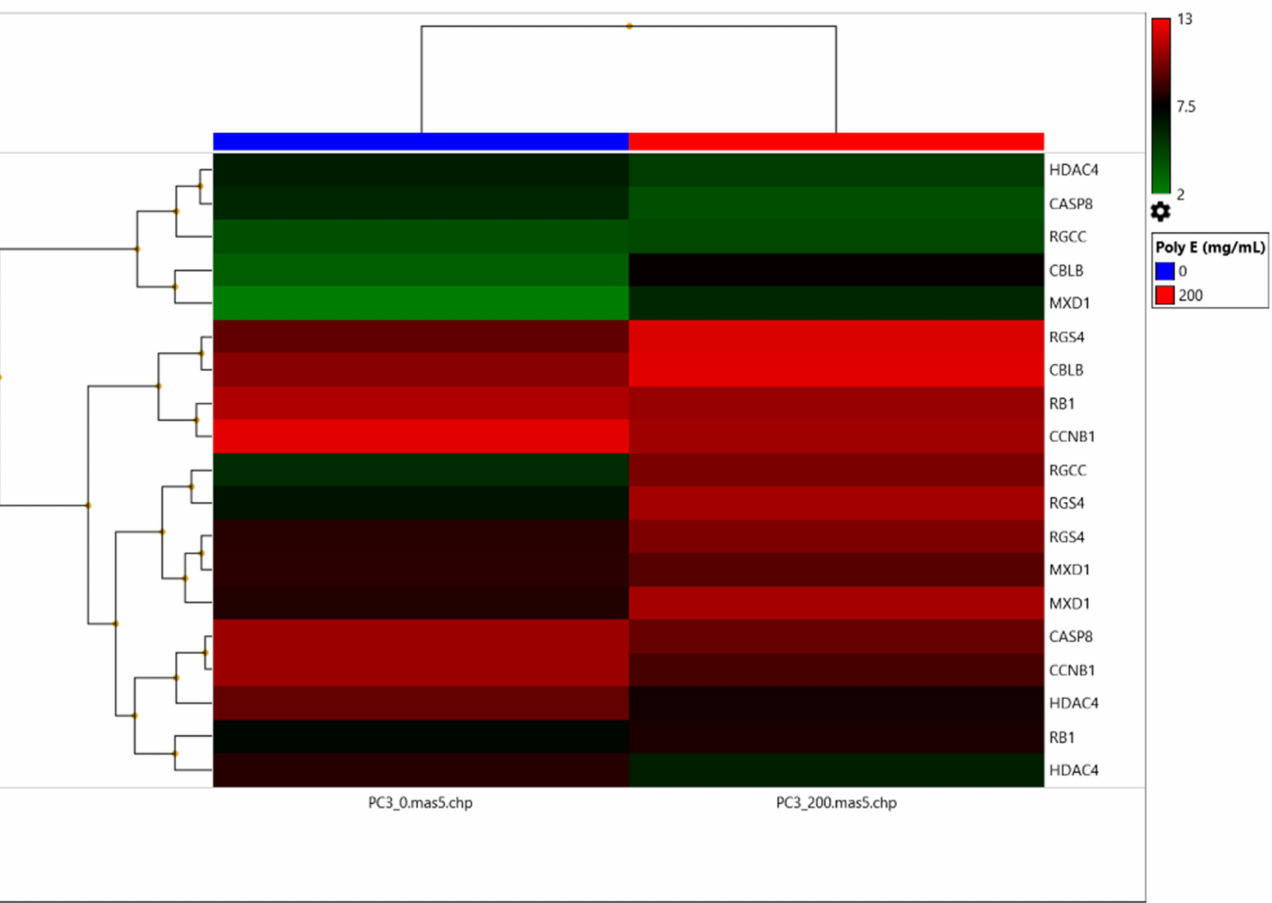
Figure 3. Poly E-treated PC-3 cell line microarray gene expression hierarchical clustering. Reporter probe signal intensities of the eight genes selected for qRT-PCR analysis are labeled with red rep- resenting upregulation and green representing downregulation in gene expression, relative to the middle-adjusted intensity depicted in black. A scale of signal intensity values ranging from 2 (lowest) to 13 (highest) is depicted at the top right of the heat map. Columns represent either untreated ( left ; 0 mg/L) or Poly E-treated ( right ; Mid 200 mg/L). Rows represent individual Affymetrix probes with gene symbols displayed to the right of each row. Hierarchical clustering of the genes analyzed is indicated by the nodal connections (left side of figure). Gene symbols (right side of figure) with their corresponding Affymetrix probe set IDs (from top to bottom of list): HDAC4 (1554322_a_at), CASP8 (1553306_at), RGCC (239827_at), CBLB (208348_s_at), MXD1 (206877_at), RGS4 (204337_at), CBLB (209682_at), RB1 (203132_at), CCNB1 (214710_s_at), RGCC (218723_s_at), RGS4 (204338_s_at), RGS4 (204339_s_at), MXD1 (226275_at), MXD1 (228846_at), CASP8 (213373_s_at), CCNB1 (228729_at), HDAC4 (204225_at), RB1 (211540_s_at), and HDAC4